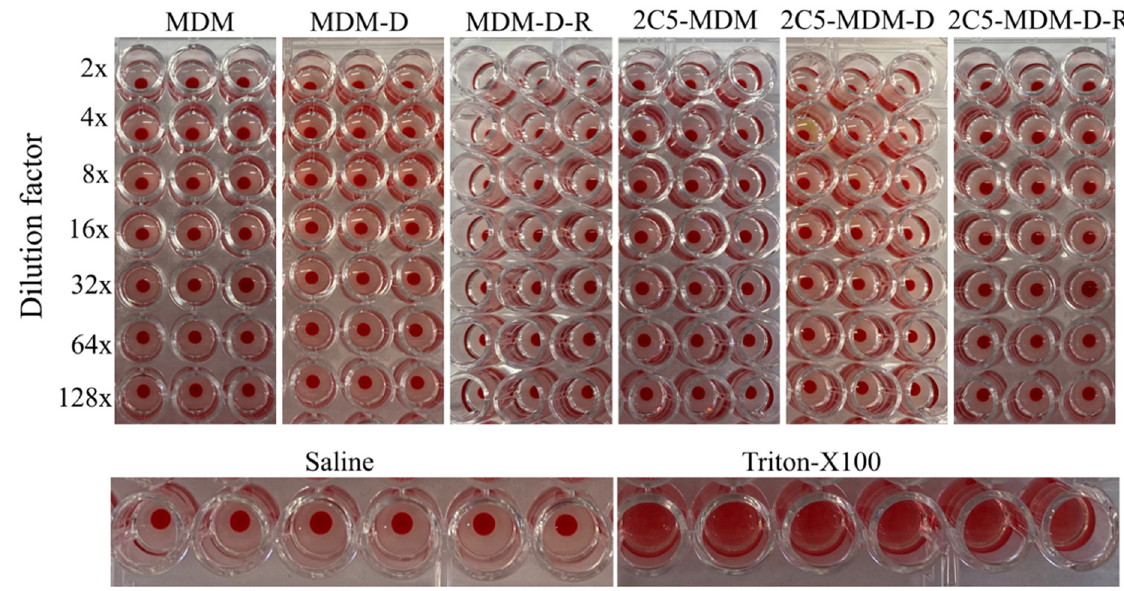
Figure 1. TEM Images of 2C5-modified mixed dendrimer micelles (2C5-MDM-DR), ( A ) 10,000× magnification, ( B ) 20,000× magnification.